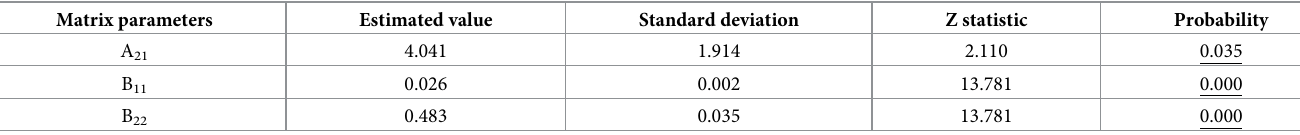
Table 6. SVAR model parameter estimate.